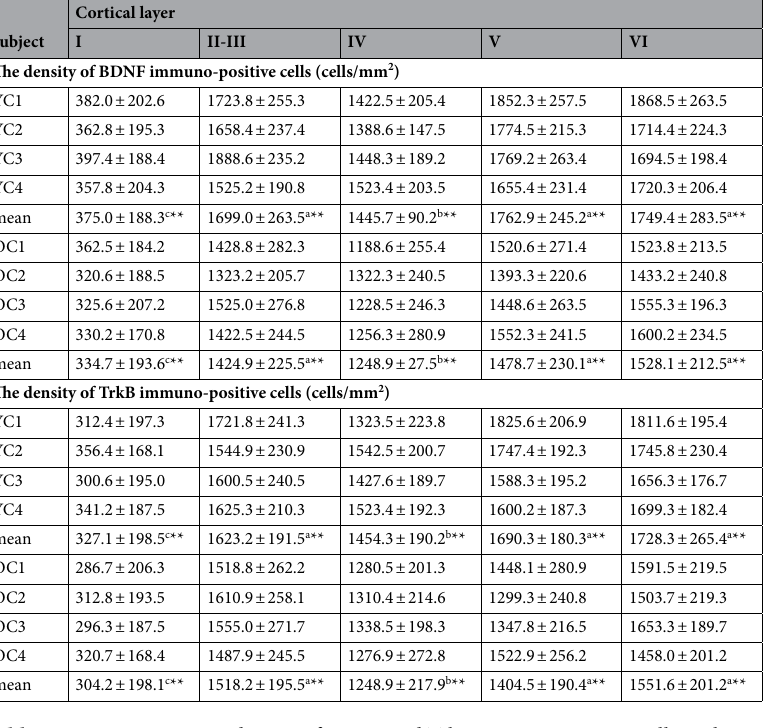
Table 1. A comparison on density of BDNF and TrkB immuno-positive cells in the primary visual cortex of young and old cats (n = 5, mean ± SD). YC1-4 and OC1-4 represent different individual from young and old cats respectively. I, II-III, IV, V and VI denote respectively in the primary visual cortical layers. The different lower-case letters indicate the density of BDNF or TrkB immuno-positive cells in this layer was significantly different from that in other layer ( One way ANOVA , LSD-way , P < 0.01). **Indicates the density of the BDNF or TrkB immuno-positive cells was declined significantly in the old cats when compared with the young cats ( One way ANOVA , P <